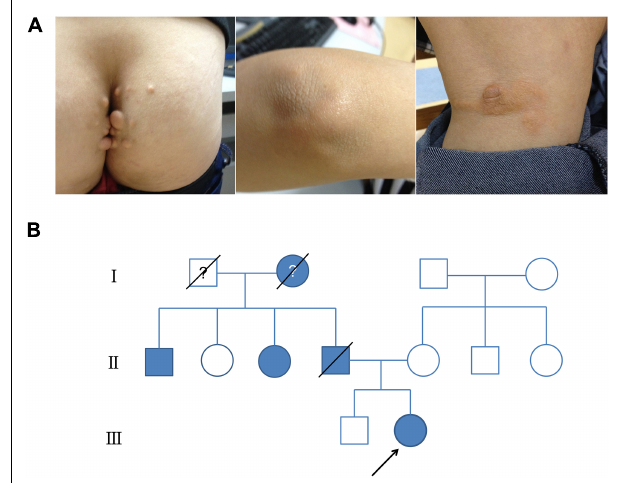
FIGURE 1 | Clinical presentation and family tree of proband. (A) Physical examination revealed multiple xanthomas on buttocks, tendon, and popliteal space on proband. (B) Family tree showing confirmed hypercholesterolemia in family of proband (colored in